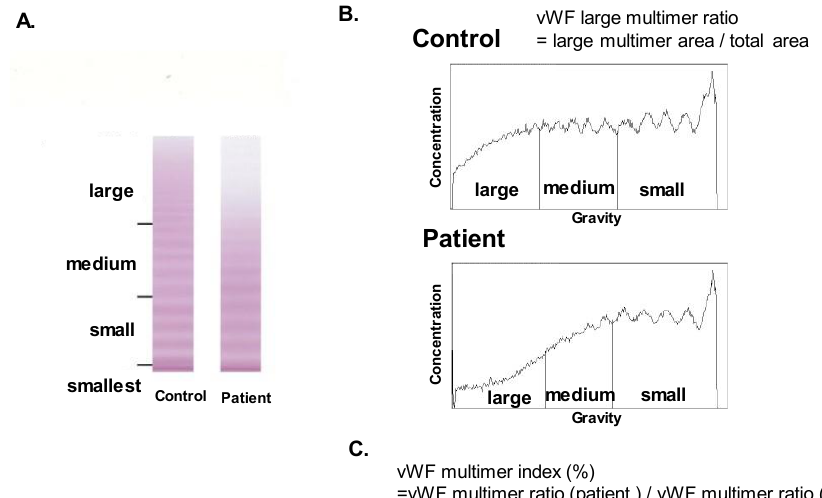
Figure 1. vWF multimer analysis by gel electrophoresis ( A ), the calculation of large-multimer ratio ( B ), and the calculation of large-multimer index ( C ). vWF multimers were divided into three parts (large, medium, and small and smallest multimers) according to their gravities ( A ). The large-multimer ratio was calculated as a ratio of the large-multimer area to the total multimers area ( B ). The large-multimer index was defined as a large-multimer ratio normalized by the value of control ( C ). vWF, von Willebrand factor.